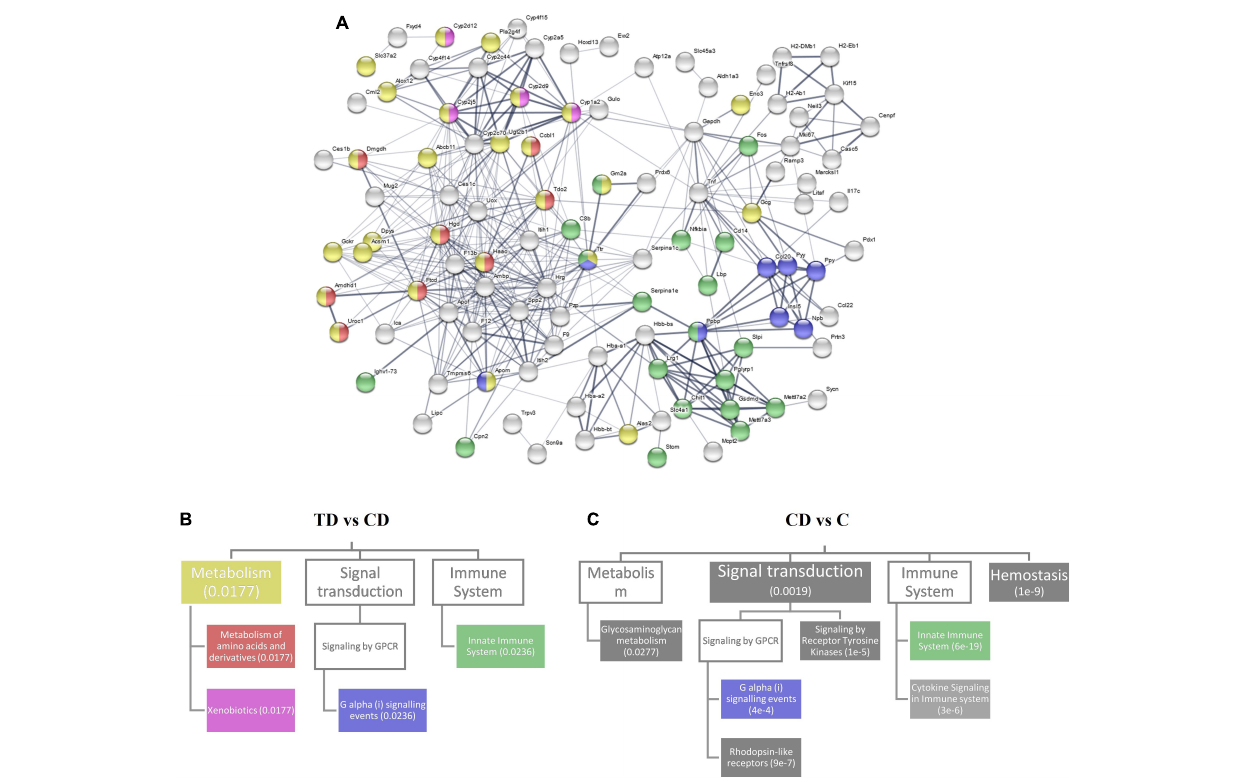
FIGURE 6 | Reactome pathway analysis. (A) Protein–protein interaction network for differential gene expression between TD and CD. (B) Top 20 related Reactome pathways for differential expression in TD and CD. The pathways are mapped in (A) with corresponding colors. (C) Top 20 related Reactome pathways for differential expression in CD and C. Numbers within parentheses represent the false discovery rate. Boxes with no color represent a false discovery rate > 0.05. TD , Tibetan tea + DSS; CD , dextran sodium sulfate-induced model; C ,